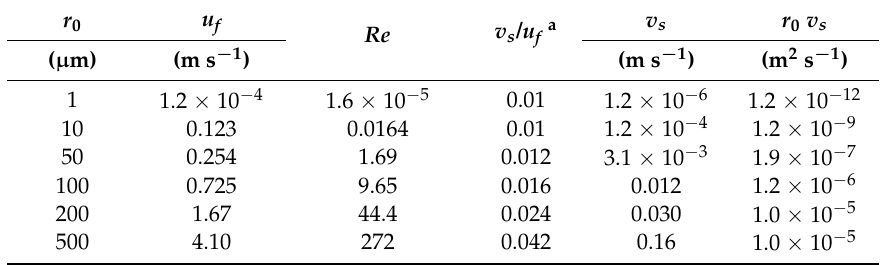
Table 1. Estimated effects of fluid motion on enhancing mixing within spray droplets. The r 0 v s is the estimate of the motion-induced diffusion within a spray droplet of the given radius. Compare these values with D g,sw , which ranges from 1.7 × 10 − 9 to 2.3 × 10 − 9 m 2 s − 1 for our six gases. In Re , the viscosity of air is calculated at 20 ◦ C and is 1.504 × 10 − 5 m 2 s − 1